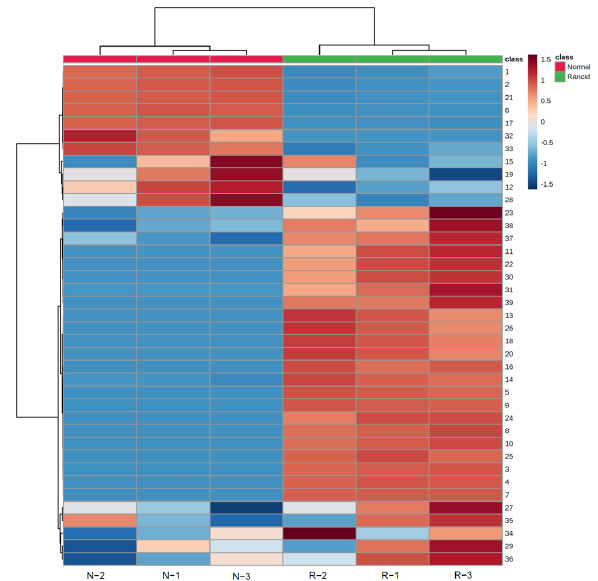
Figure 3. Heat-map and HCA of volatile compounds in normal and rancid samples. N − 1, N − 2, and N − 3 represent normal samples. R − 1, R − 2, and R − 3 represent rancid samples. The numbers on the right represent the compound number of Table 3. The deeper the red, the higher the content; the deeper the blue, the lower the content of the compound in the samples.